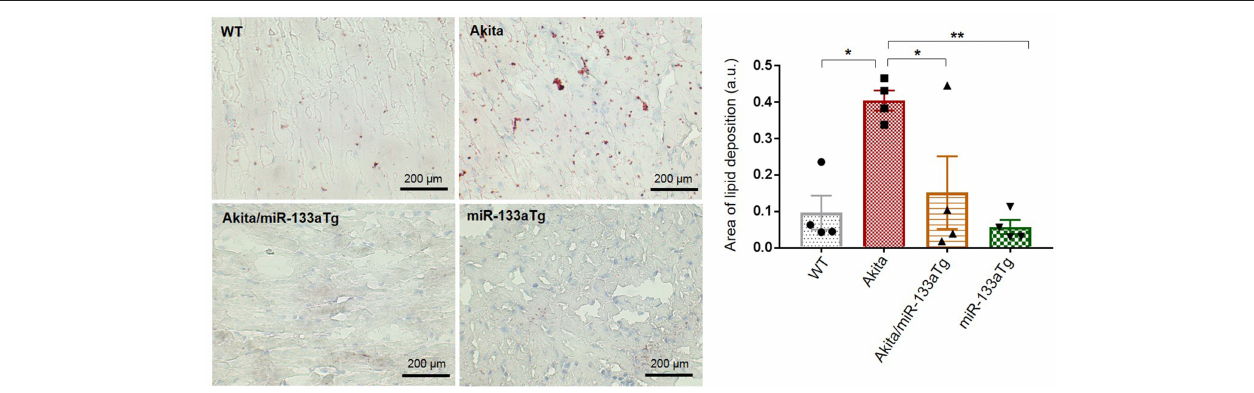
FIGURE 3 | Cardiac-specific miR-133a prevents DM-induced lipid accumulation in the heart. Oil Red O staining of the heart cryosections. Representative left ventricle heart section of WT, Akita, Akita/miR-133aTg, and miR-133aTg mice (400 × magnification). Quantification of red color in bar graph. Values are presented as mean ± SEM. One-way analysis of variance (ANOVA) followed by Tukey’s test was used for statistical significance. Red color represents lipid deposition and light blue color represents nuclei. N = 4 per group. * P < 0.05; ** P < 0.01.